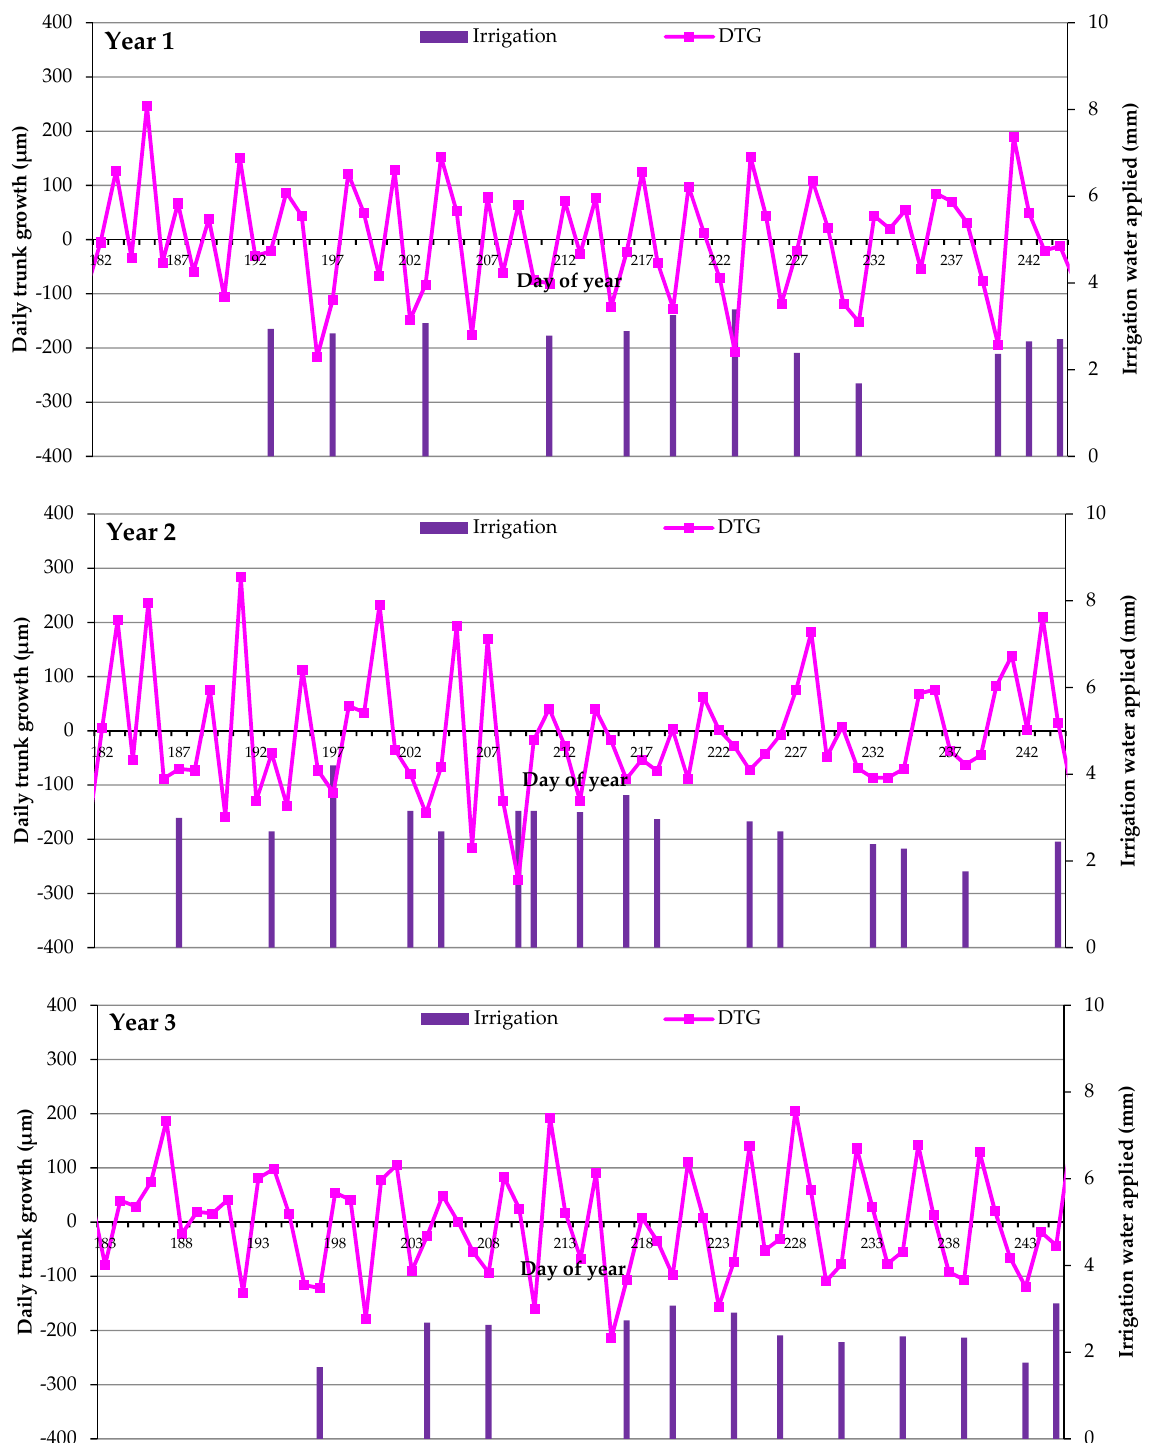
Figure 1. Daily trunk growth (DTG) during summer (µm/day) was used to support the decision- making process for Precision irrigation during three tested years. Bars represent the date and amount of water applied during each irrigation. The X -axis represents the day of the year.